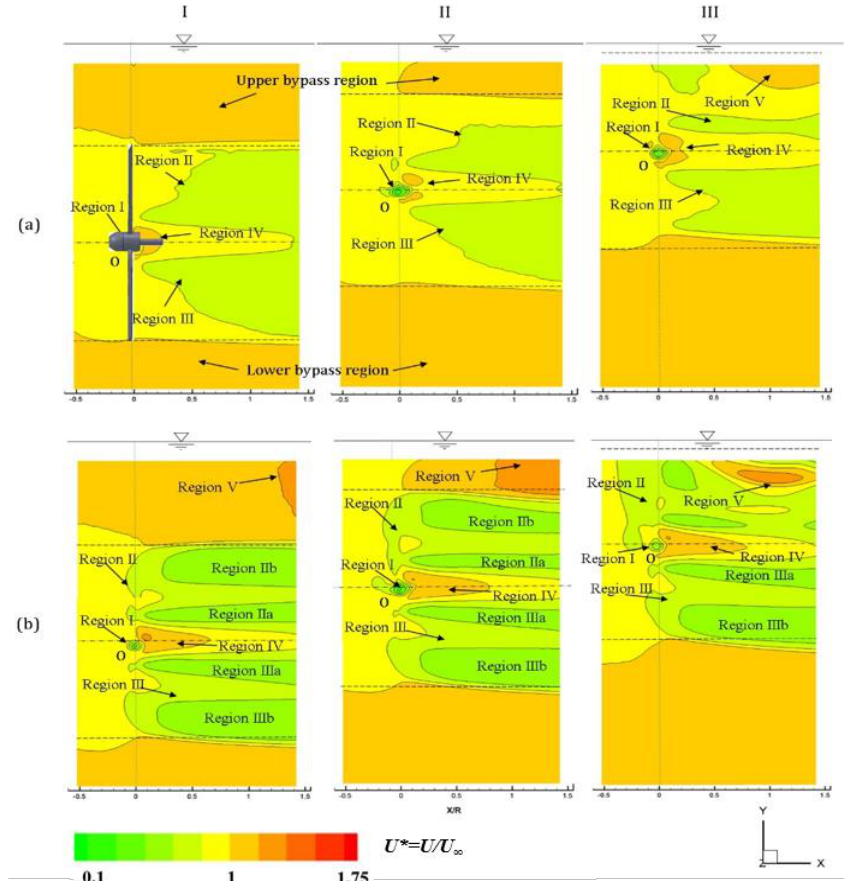
Figure 3. Time-averaged contours of normalized stream-wise velocity ( U * = U / U ∞ ) for δ h U = 0.55 (column I), 0.27 (column II), and 0.05 (column III) at rotational speeds of 180 RPM (row a) and 270 RPM (row b). The center line represents the turbine axis location while the dotted lines represent blade tip location.